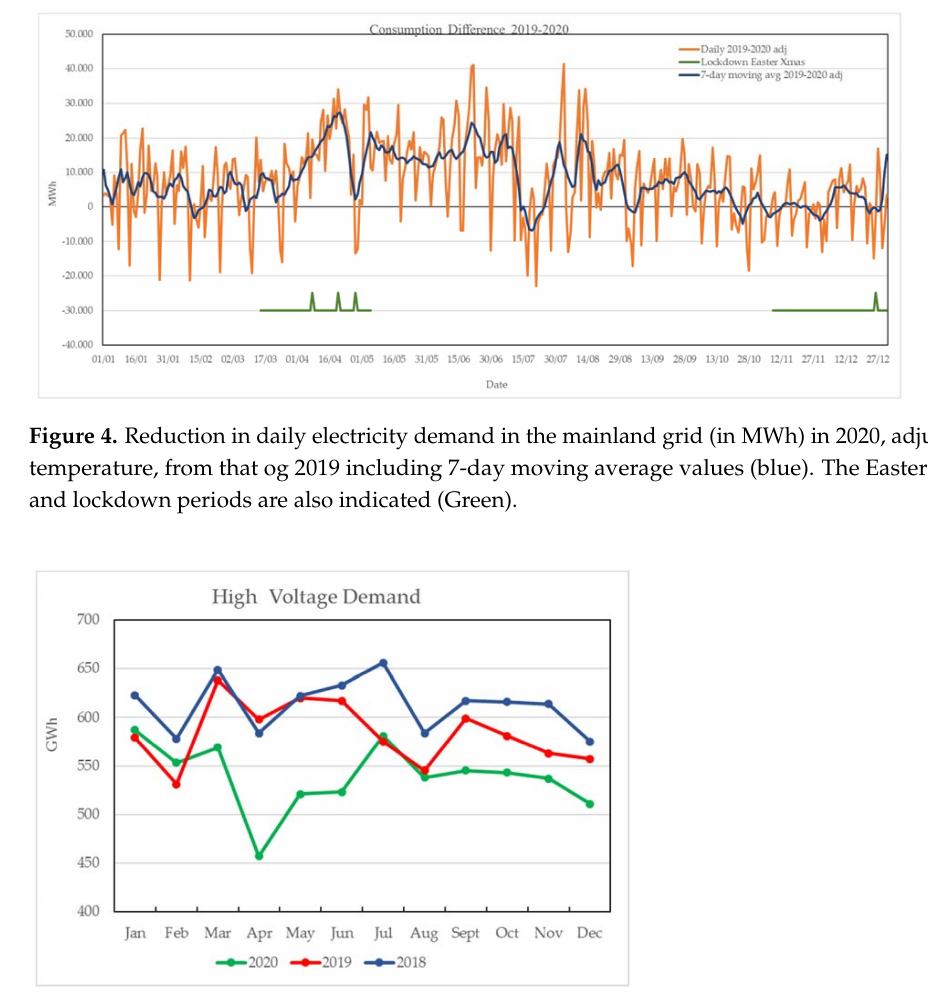
Figure 5. Monthly amounts of electricity demand of the high voltage customers for 2018, 2019, and 2020